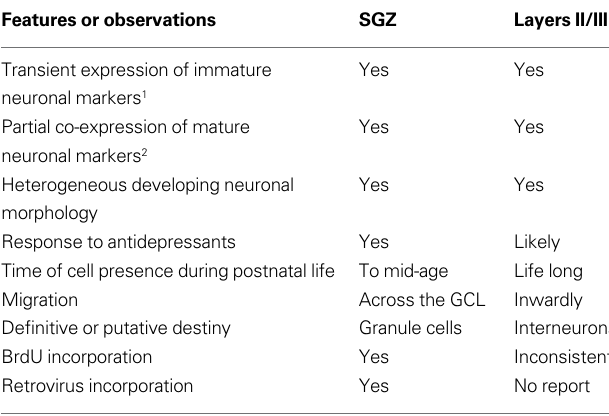
Table 1 | Comparison of hippocampal with cortical DCX +